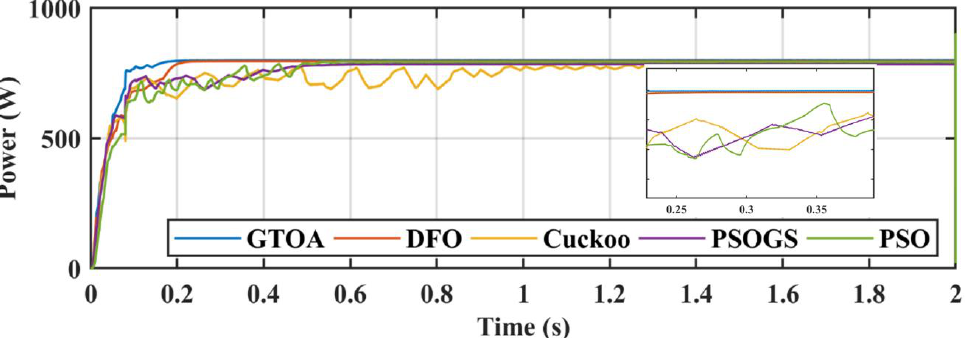
Figure 22. Zoomed-in comparison of power of GTOA.